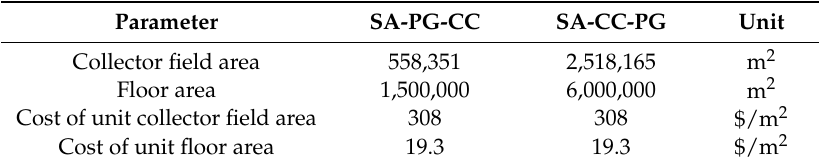
Table 6. Economic parameters of solar fields for solar-aided coal-fired power generation with CO 2 capture (SA-PG-CC) and solar-aided CO 2 capture coal-fired power generation (SA-CC-PG).